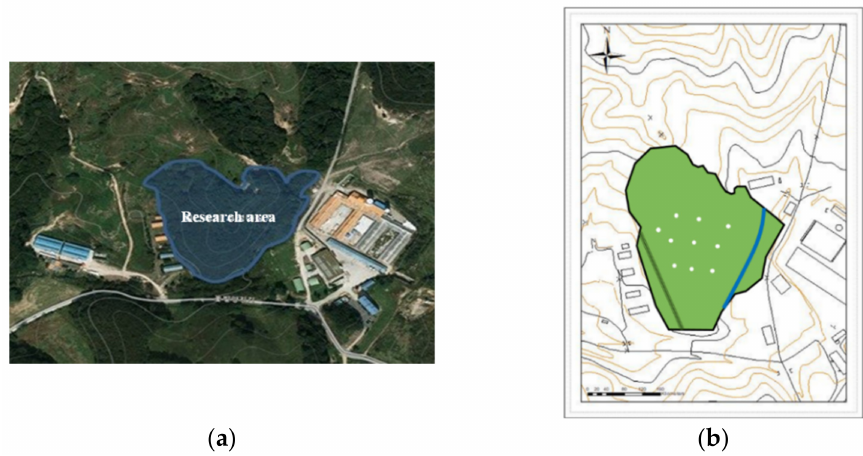
Figure 1. ( a ) The survey area in Pyeongchang county, Gangwon province, South Korea. ( b ) The 2.3 ha survey area and 10 sites within the grasslands created in the forest. The blue line represents a valley, while the green line represents a dry